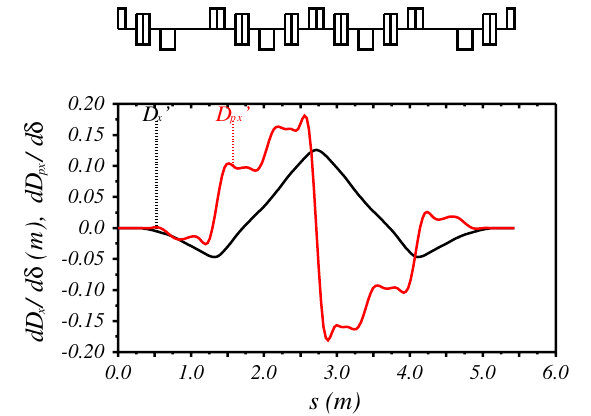
FIG. 5. Second-order dispersion T 166 and angular dispersion T 266 of one supercell which consists of four FODO cells, under the missing dipole configuration.